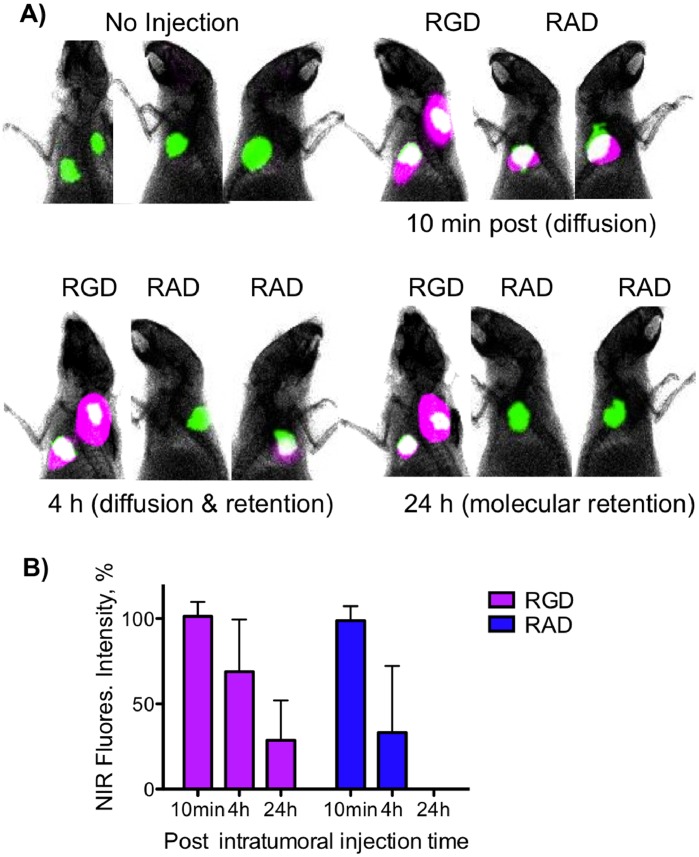
Tumor targeting by DMR by using the GFP expressing BT-20 breast carcinoma xenograft visualized by surface fluorescence.A) Two animals bearing two tumors were PT injected with the RGD probe or RAD probe as indicated and surface fluorescence images were obtained. With the RAD injected animal, tumors were more sagittal so two views of the same animal are provided. Green = GFP. Purple = probe. White = green+purple overlay. The RGD probe diffused around the tumor and is retained while the RAD probe was eliminated. B) Quantitation of tumor surface fluorescence after injections of the RGD or RAD probes as above. Surface fluorescence was quantified through the use of standard solutions. Only the RGD probe was retained by the tumor. n = 4, values are mean ± SD.